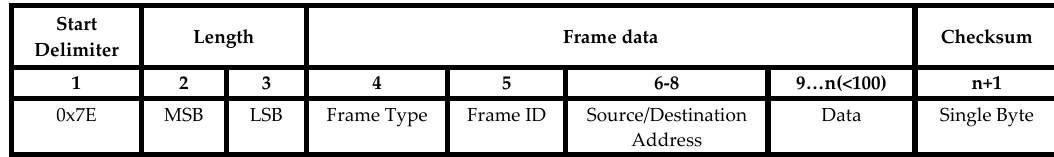
Figure 7 . API frame structures for Xbee transmit and receive a request . Figure 7. API frame structures for Xbee transmit and receive a